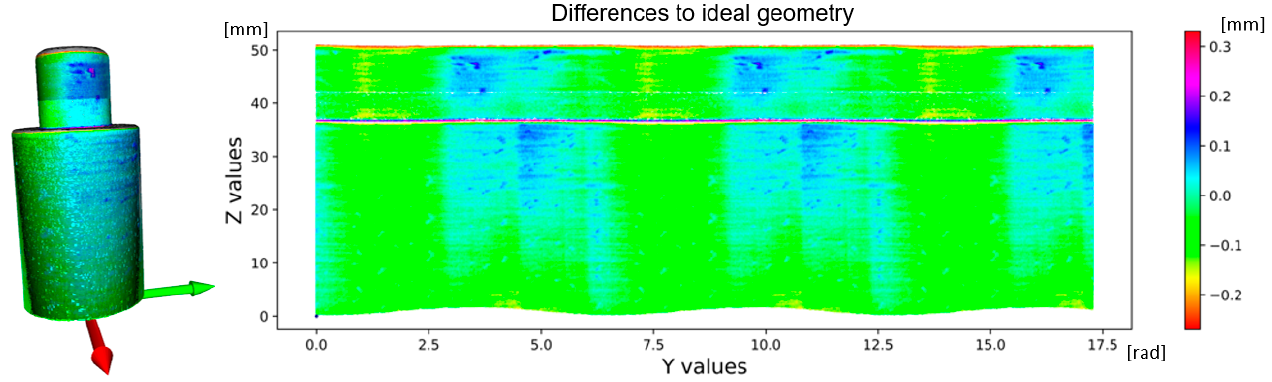
Figure 13. Illustration points to displacement from the nominal shape of the shaft. Left-side—3D visualization scanned shaft; right-side—flatten surfaces of scanned shaft.